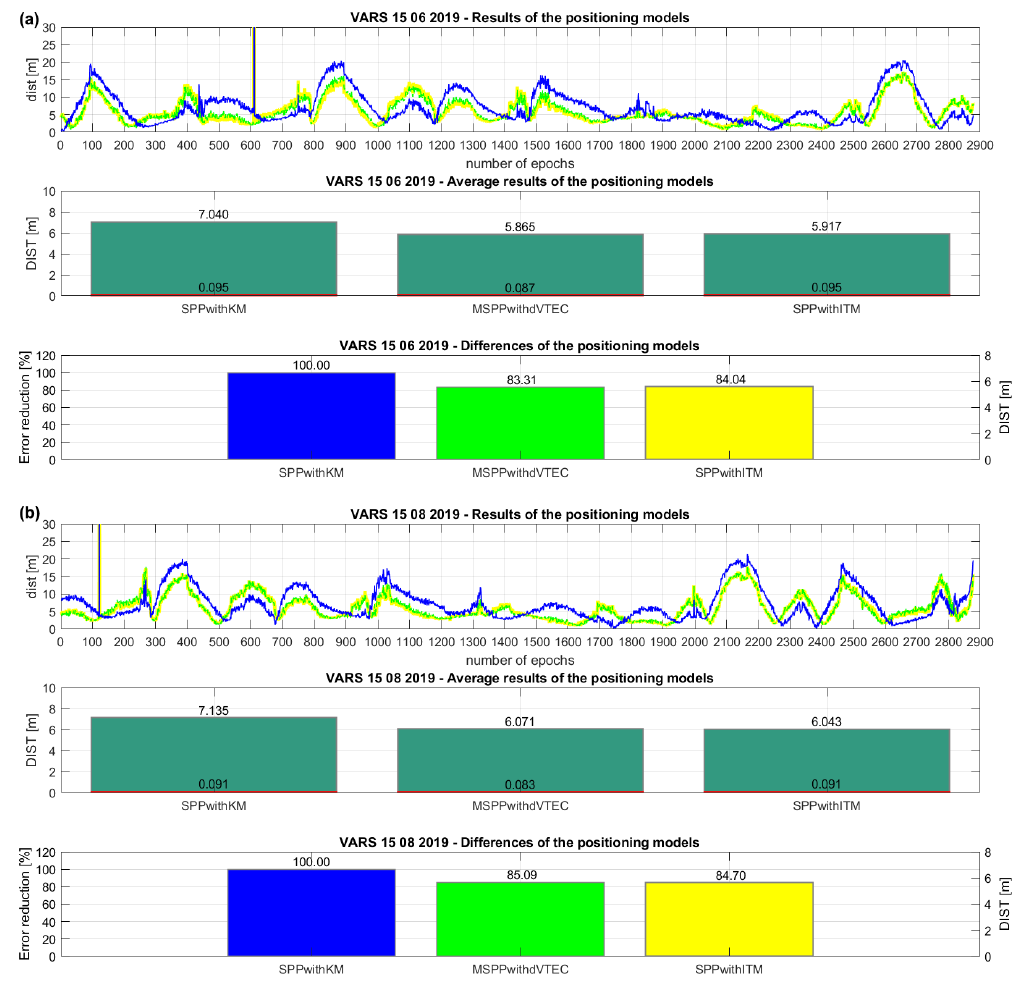
Figure 3. Set of the results of the positioning models: (a) VARS 15 June 2019 and (b) VARS 15 August 2019.